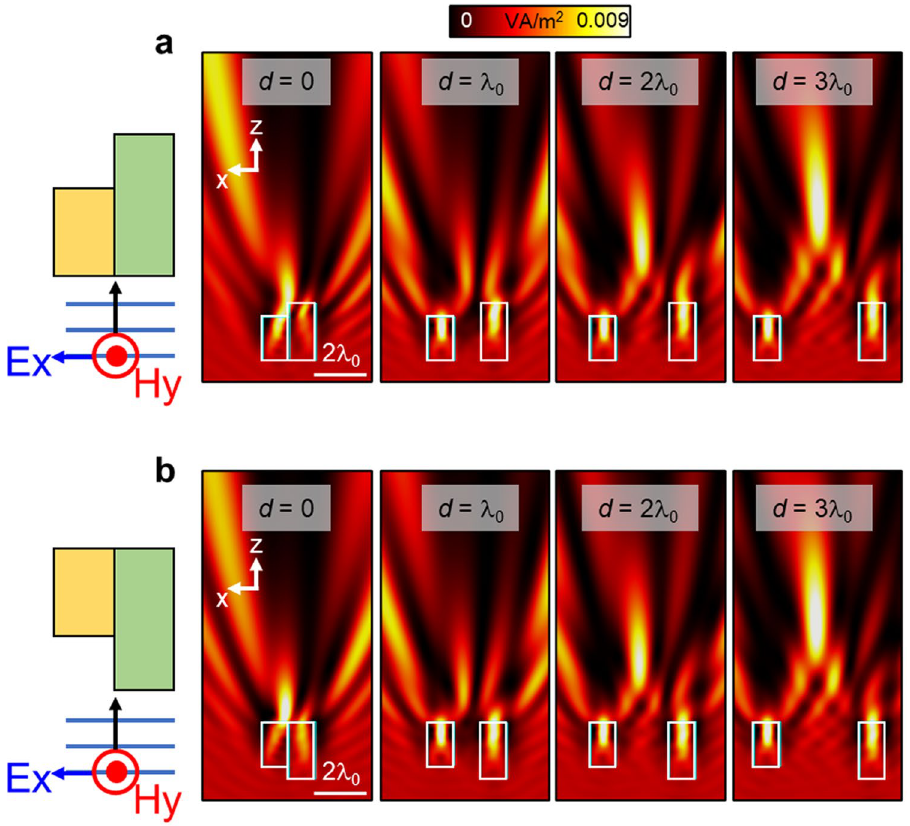
Figure 2. Examples of photonic hooks using full asymmetric dual dielectric structures. ( a , b ) Numerical results of the power distribution on the xz plane for a dual-dielectric structure designed to produce maximum scattering (right dielectric) and minimum diffraction (left dielectric) at z = 4 λ 0 from the output surface of each individual dielectric. The dielectrics have a refractive index of n 1 = 1.3 and n 2 = 1.5 with a length along the propagation z- axis calculated from Fig. 1b, c of L z1 = 2.17 λ 0 and L z2 = 1.67 λ 0 , respectively. We consider different values of d ranging from 0 up to 3 λ 0 and two configurations: ( a ) dielectrics aligned at their input surface and ( b ) dielectrics aligned at their output